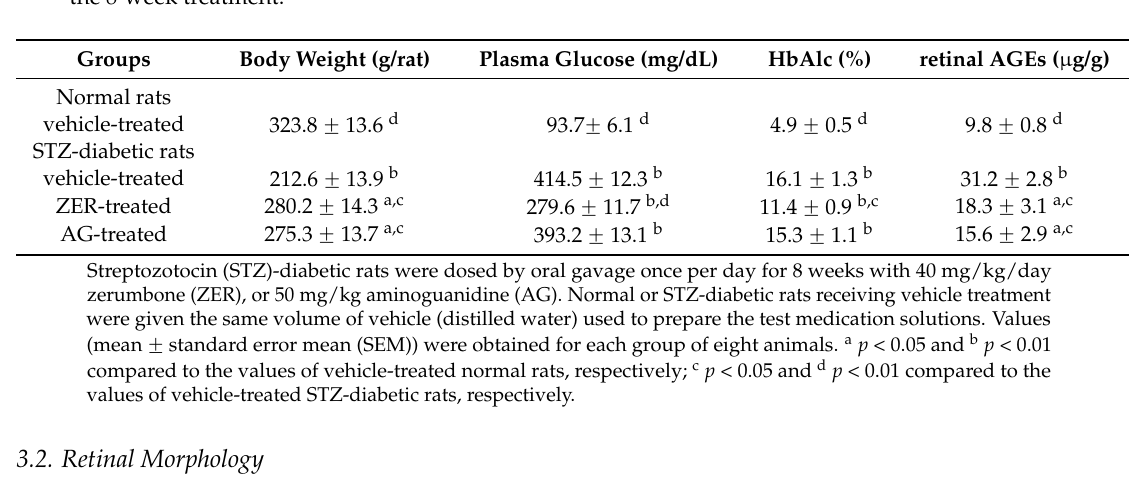
Table 1. Changes in the body weight, plasma levels of glucose and glycosylated hemoglobin (HbA1C) and retinal advanced glycosylated end products (AGEs) content in experimental animals at the end of the 8 ‐ week treatment.